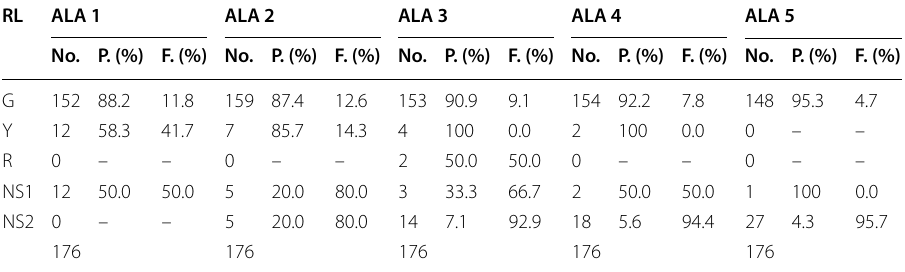
RL is the different risk levels (G, Green; Y, Yellow; R, Red; NS1, Not submitted No. is the number of learners identified in that level, P. is the percentage of learners identified in that level that passed the course, and F. is the percentage of learners in that level that failed the course